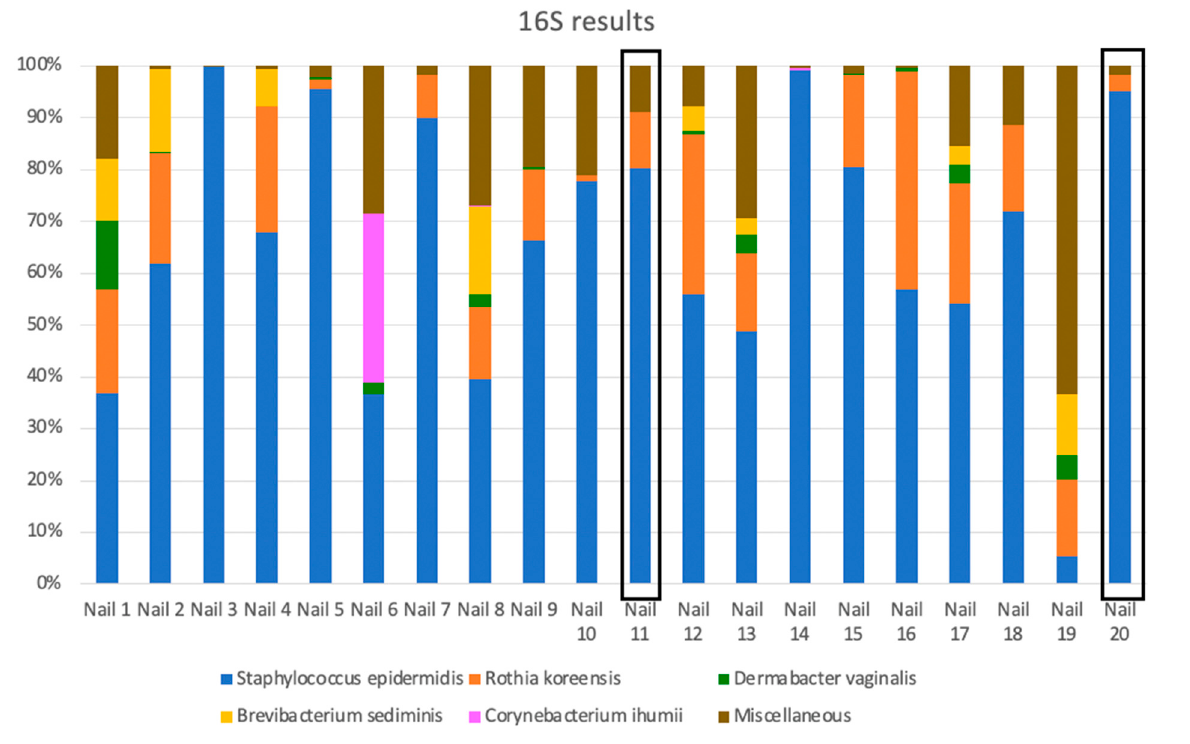
Figure 3. Main bacteria found in mycotic and normal control nails. Stacked histograms show dominant species results of 16S region analysis for all nails. Normal control nails are boxed in black.